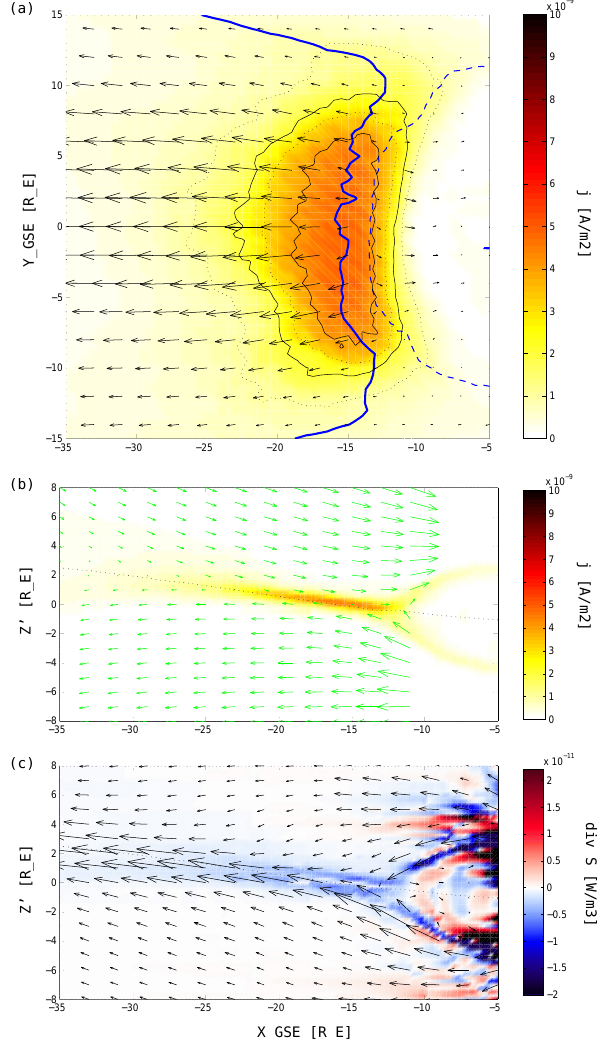
Fig. 9. The reconnection region at 5:20 UTC, when the reconnec- tion rate peaks, during the substorm of 15 August 2001. Same scales as in Figs. 4 and 5. (a) The current sheet from above. Colour- ing and black contour lines depict current density, and arrows are plasma flow velocity vectors. The thick solid blue line is the mag- netic x-line and the dashed blue line is the flow reversal line. (b) The perpendicular plane. Colouring is current density and arrows are magnetic field vectors on the plane. (c) The perpendicular plane again. Now the colouring is the divergence of the Poynting vector, ∇· S , and the arrows are plasma flow velocity